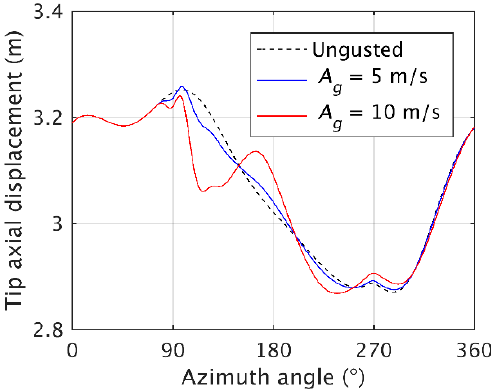
Figure 10. Zero net flow rate gusts: tip axial displacement as a function of its azimuth angle in all analyzed cases.